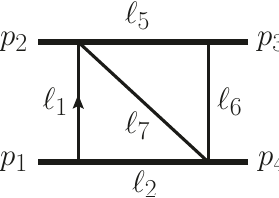
Figure 26 . The H graph with momentum assignments. The 7 propagators carrying momentum ‘ i correspond to the propagators in eq. (8.1). The external momenta are all outgoing and the direction of the independent loop momenta are indicated by the arrows.